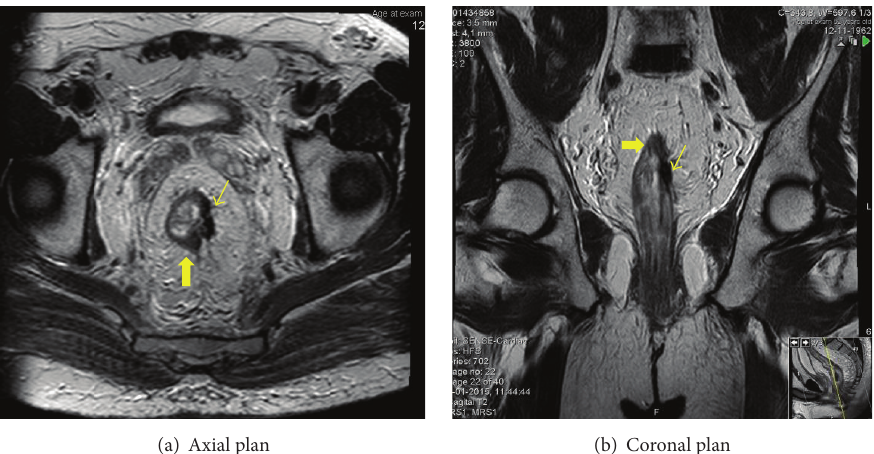
Figure 3: MRI 11 weeks after CRT completion. Good tumor response: tumor downsizing and downstaging, nodal downstaging, and increase between tumor and mesorectal fascia. Thin arrow: areas of fibrosis (very low signal intensity); thick arrow: areas of residual tumor (intermediate signal